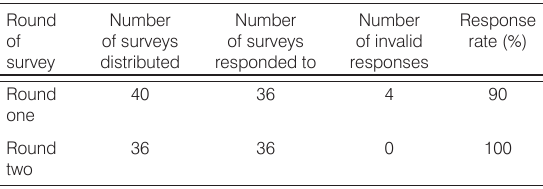
Table 3. Survey on the eligibility criteria and training content for prescriptive authority for midwives